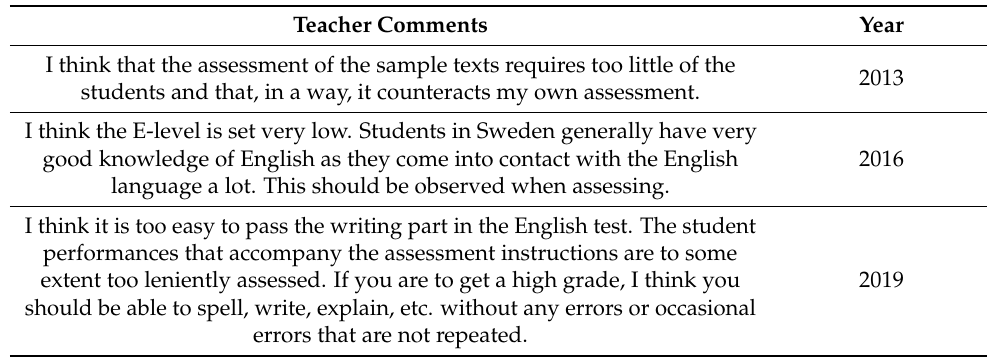
Table 9. Examples of teacher comments criticizing the assessment of writing/Part C (2013, 2016 and